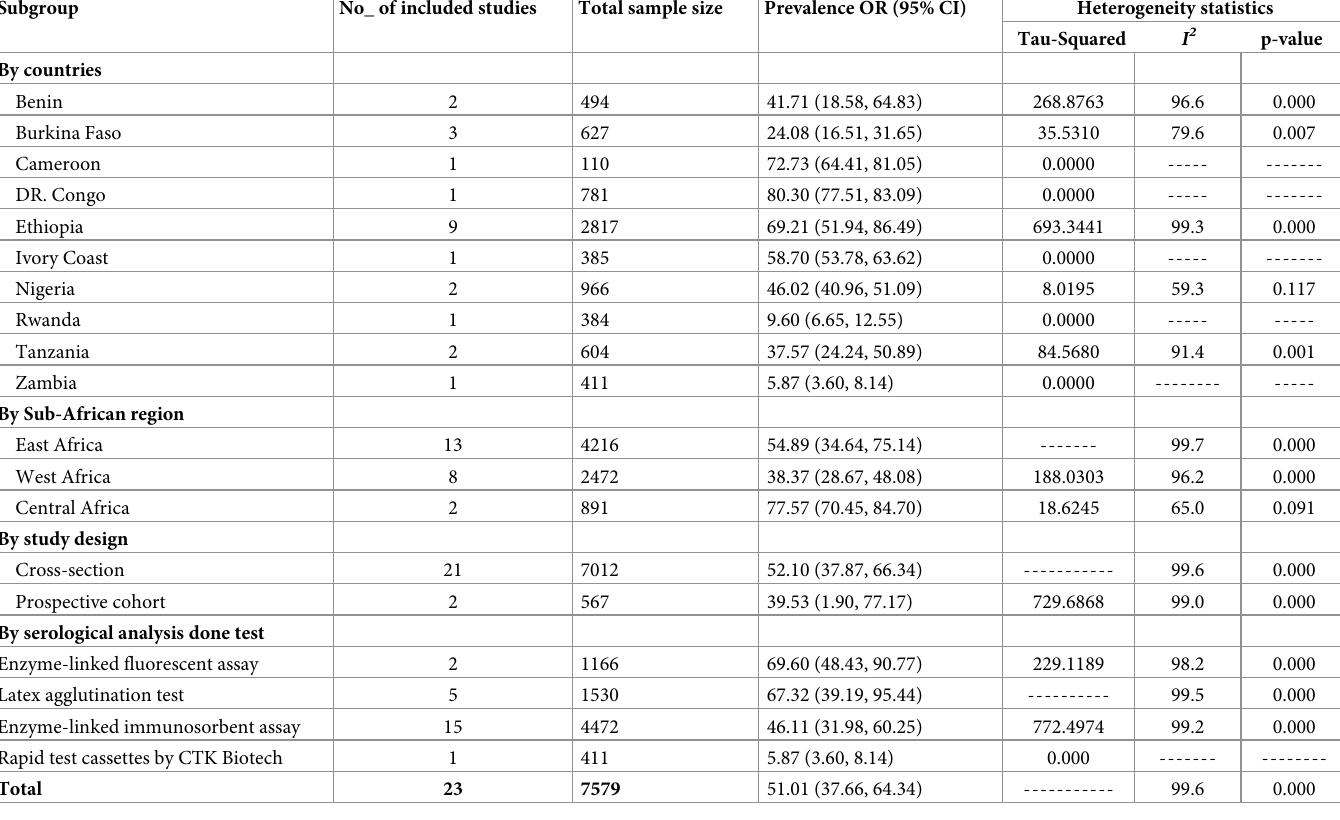
Table 2. Subgroup analyses for the prevalence of toxoplasmosis pregnant women in Africa.